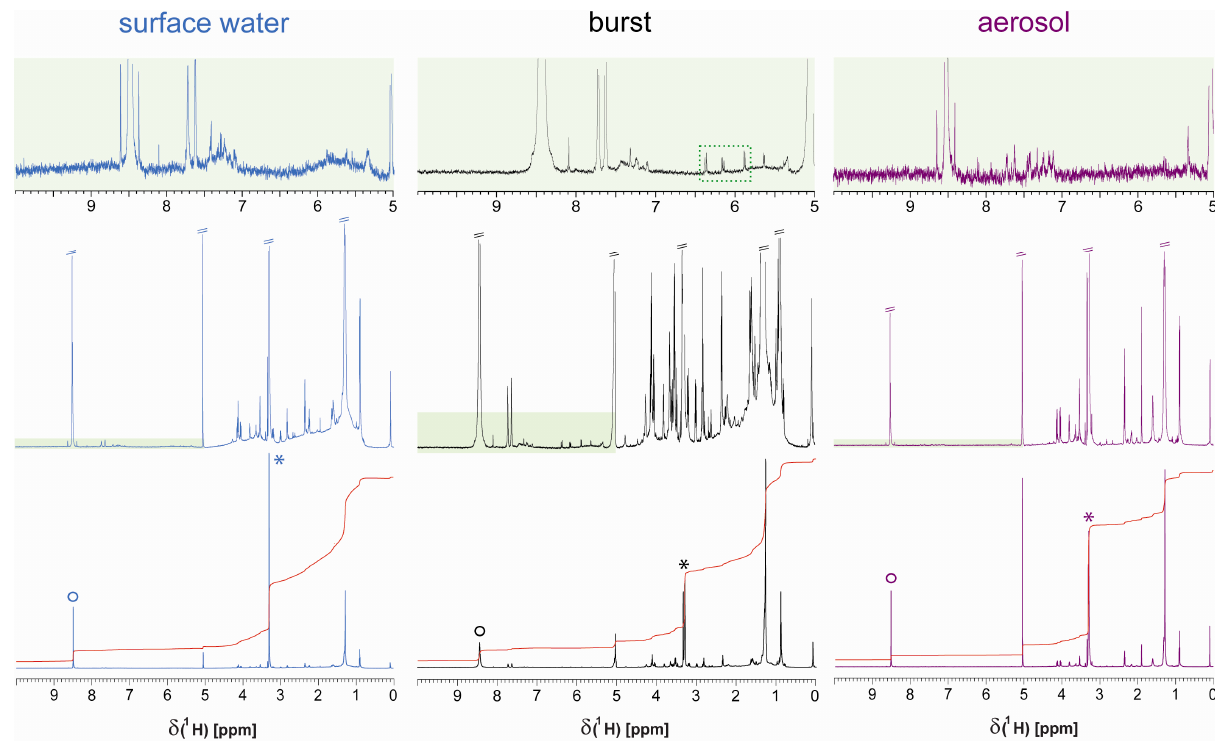
Fig. 7. 500MHz 1 H NMR spectra of surface water, burst, and aerosol in CD 3 OD ( δ H =3.30ppm;asterisk). Bottom panel: entire spectrum ( δ H =0...10ppm) with (middle panel) vertical expansion with identical chemical shift scale. Top panel: expanded section of unsaturated ( δ H =5...10ppm) proton chemical environments with individual intensity adjustments (cf. green highlighted rectangles) to reveal also molecules of little abundance. Note the intensity ratio of the formic acid HCOOH ( δ H =8.52ppm; circle) NMR peak compared with the other signals; the two adjacent signals are the 13 C satellites [ 1 J( 13 C- 1 H)=191Hz] with 0.5% abundance of the central signal. Green dotted box shows chemical shift range indicated in Fig. 8, panel B.